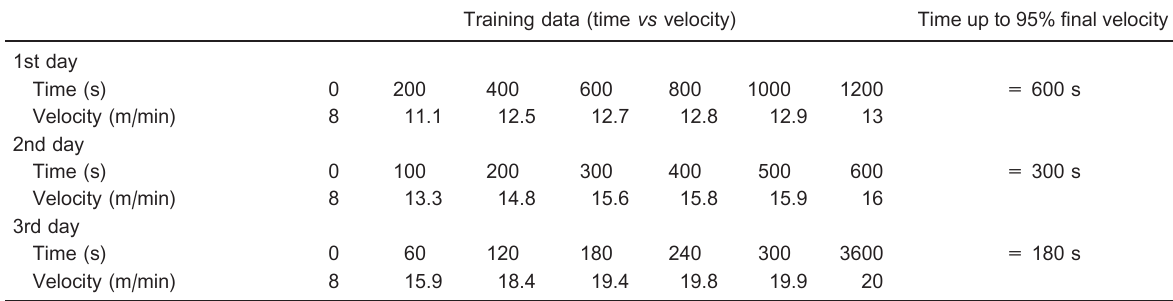
Table 1. Experimental training data from the first to the third